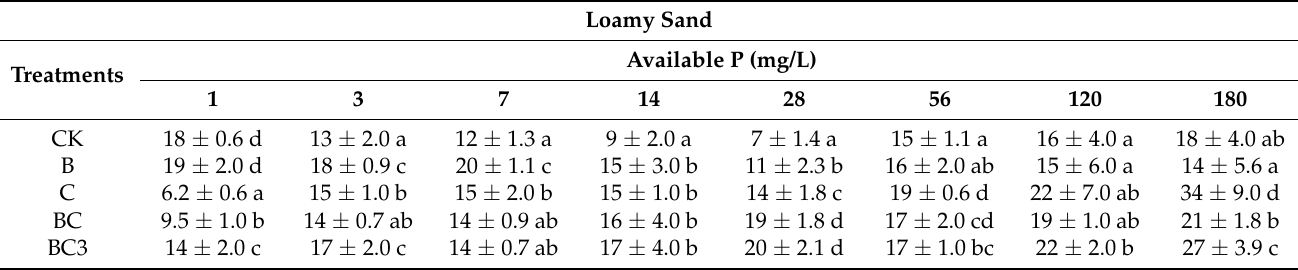
Table 4. Dynamic changes in available P content in the experimental soil solutions. Loamy Sand